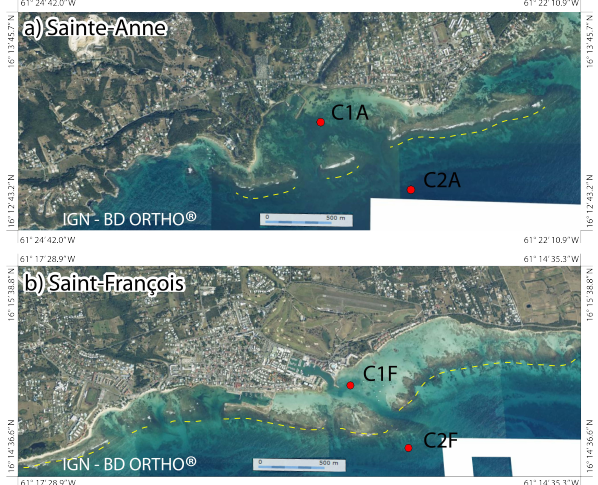
Fig. 2. Aerial view (from IGN-BD ORTHO project, extracted from http://www.geoportail.fr and re-projected in geographical coordi- nates in WGS84 geodetic system) of Sainte-Anne (a) and Saint- Franc¸ois (b) highlighting their coral fringing reefs with yellow dashed line. These towns are located on the inset of Guadeloupe (Fig. 1c). Red circles symbolize synthetic tide gage